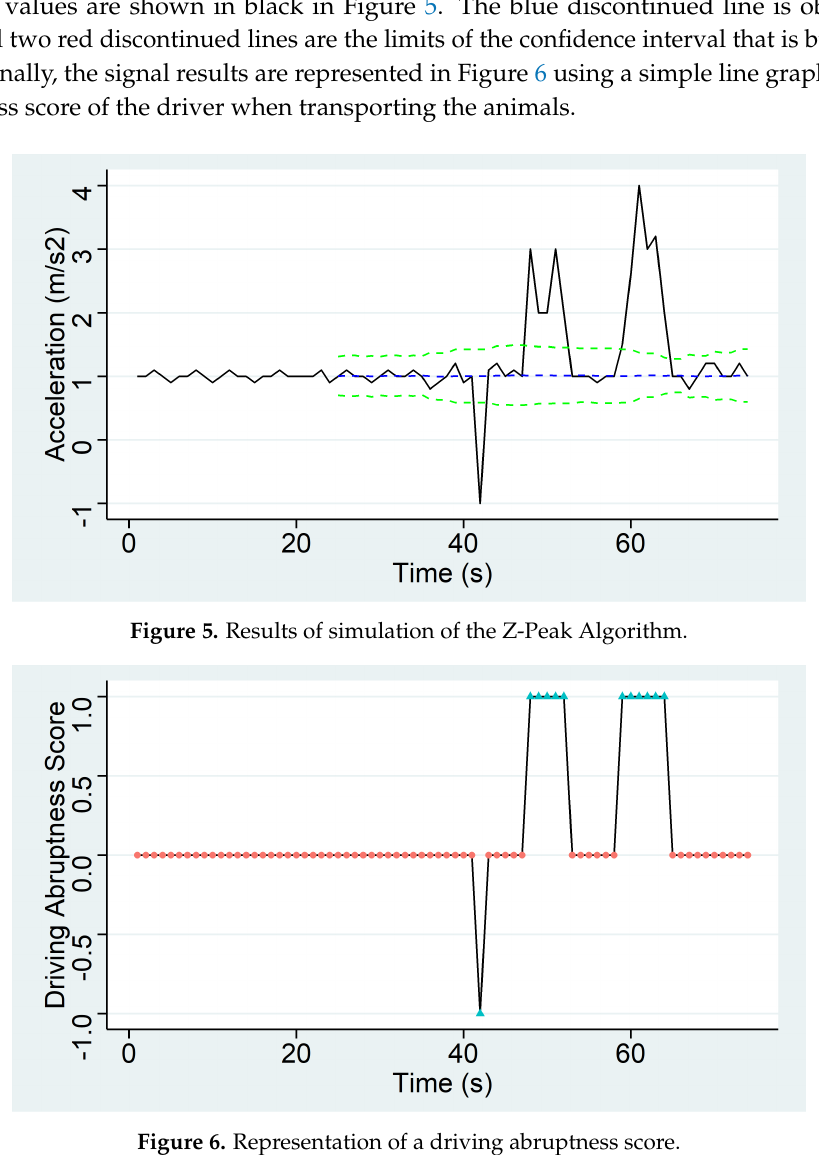
Figure 6. Representation of a driving abruptness